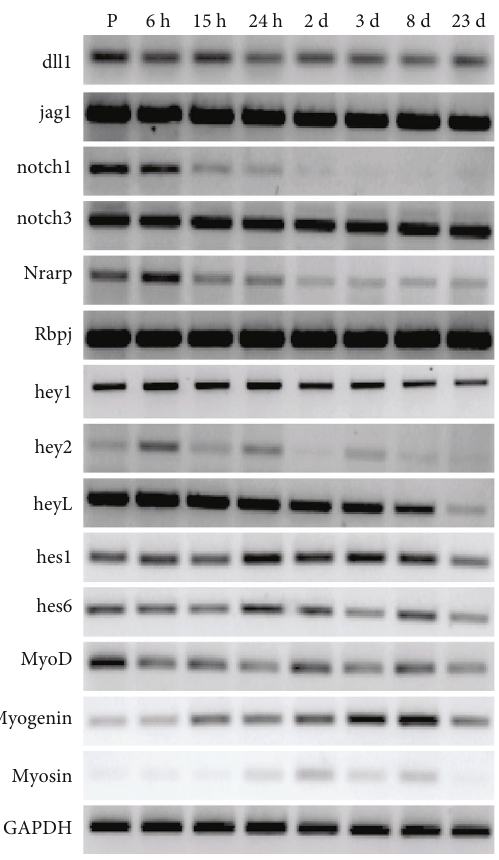
Figure 5: Expression of notch pathway genes in proliferating cells and in myospheres at di ff erent stages by RT-PCR. The fi gure summarizes experiments performed more than three times.